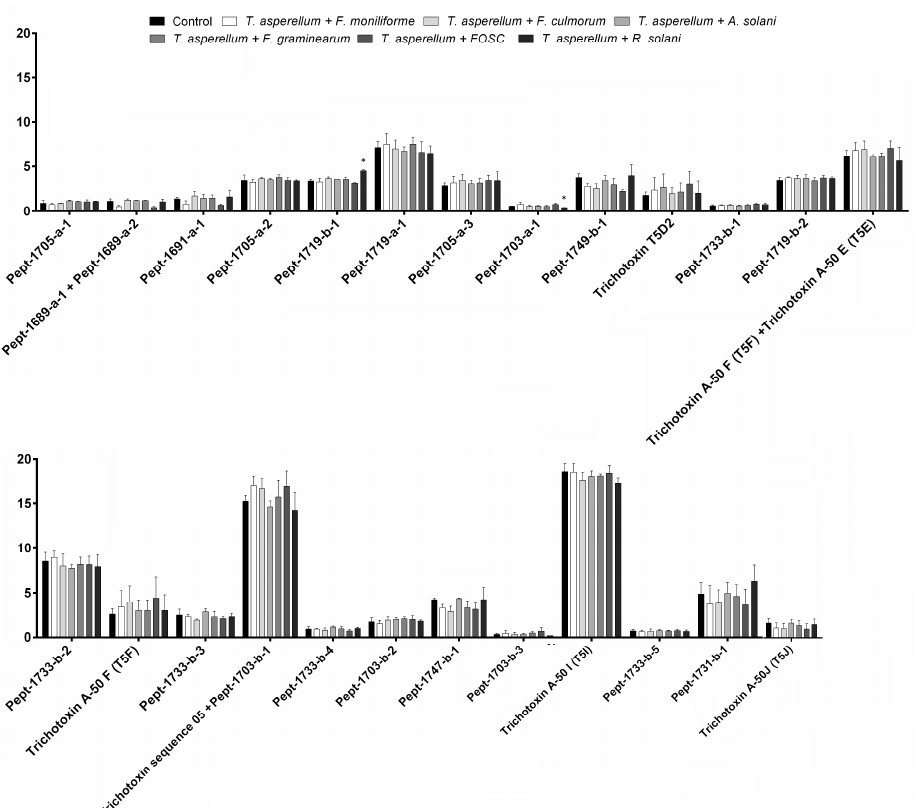
Figure 7. Relative amounts of peptaibols by Trichoderma asperellum IRAN 3062C in interaction with plant pathogenic fungi ( Fusarium moniliforme , F. culmorum , F. graminearum , FOSC, Alternaria solani , Rhizoctonia solani ) compared with the control ( Trichoderma without plant pathogen) in confrontation tests. Asterisks indicate significant di ff erences, as determined by Student’s t test (* p < 0.05) corrected with the Holm–Šidak method.